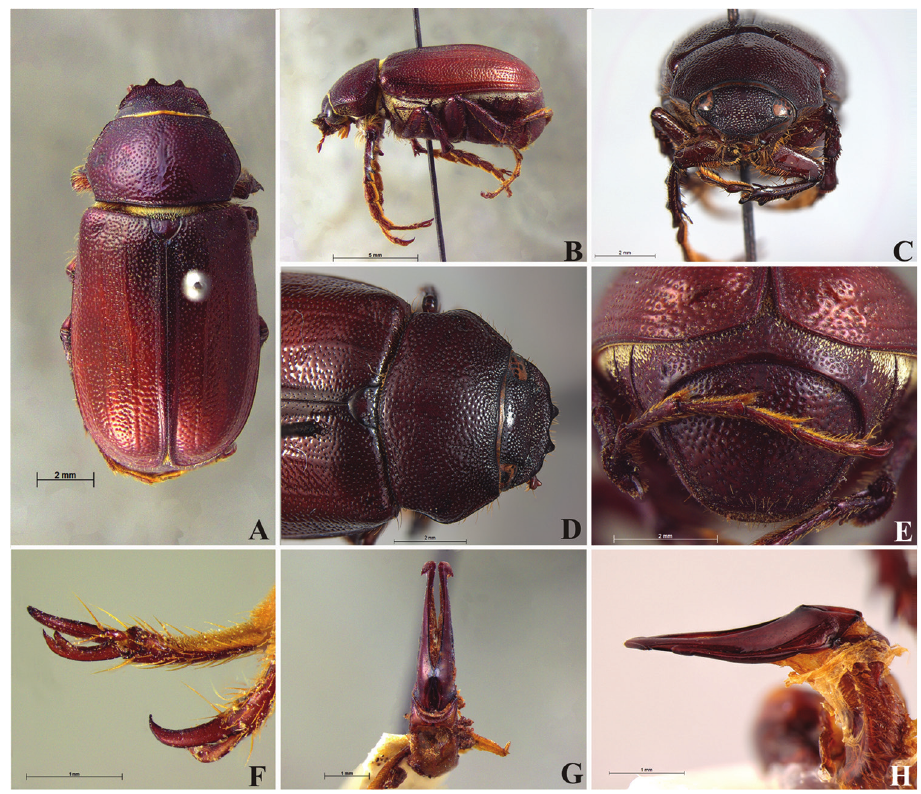
Figure 64. Liogenys fusca Blanchard. A Dorsal view B Lateral view C Frontal view D Clypeus and pro- notum E Pygidium F Male protarsal claw G Parameres, dorsal view H . Parameres, lateral view.